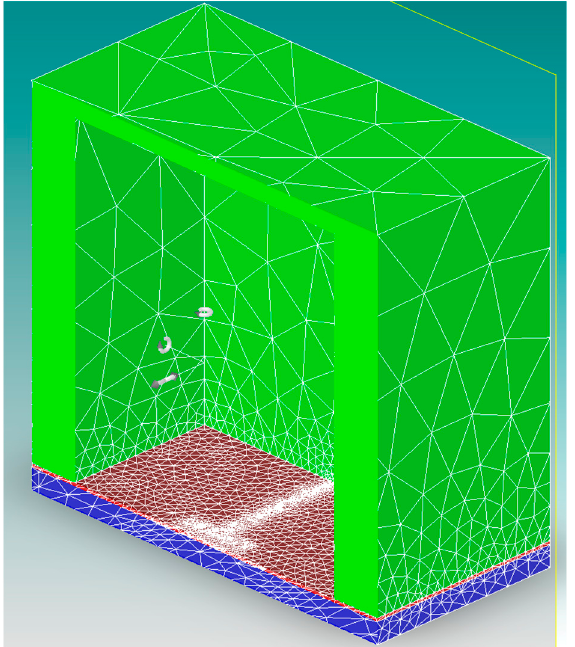
Figure 5. Distribution of the generated mesh on the model of the microheater–culture system (cross ‐